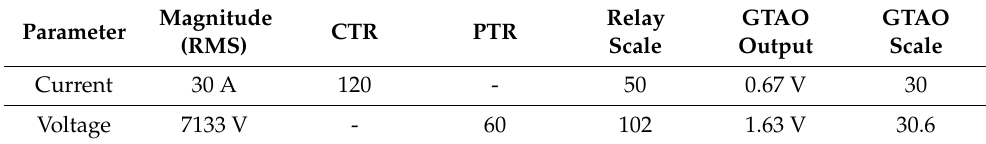
Table 3. Parameters for GTAO card.